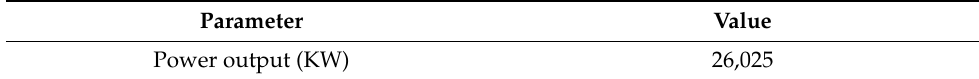
Table 4. Objective function.